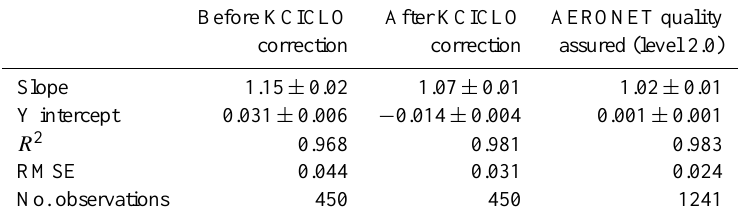
Table 2. Least squares linear fit results (dimensionless) between the NOAA handheld sun photometer AOD measurements and three Cimel sun photometer AOD data sets (AERONET level 1.5 before and after KCICLO correction, and AERONET level 2.0). The parameters are the following: slope of the regression, Y intercept, correlation coefficient ( R 2 ) , root-mean-square error (RMSE), and number of